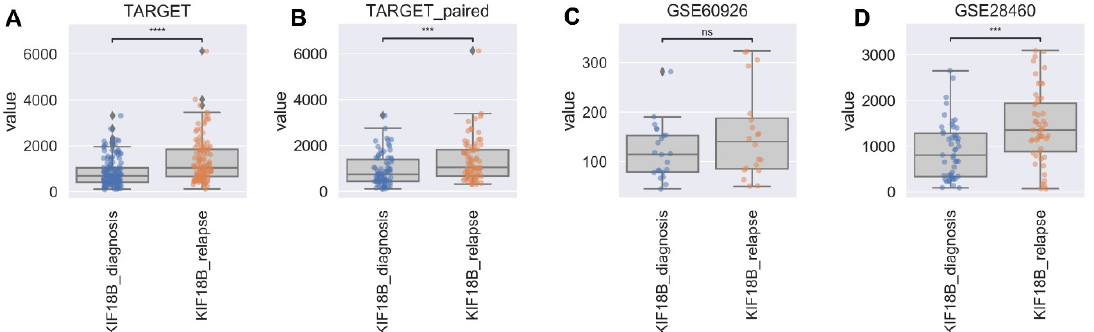
Figure 1. Differences in expression levels of KIF2C . Comparison of KIF2C expression levels in ( A ) TARGET, ( B ) TARGET_paired, ( C ) GSE60926, and ( D ) GSE28460 (**** indicates significance at p value <0.0001, *** indicates significance at p value <0.001).